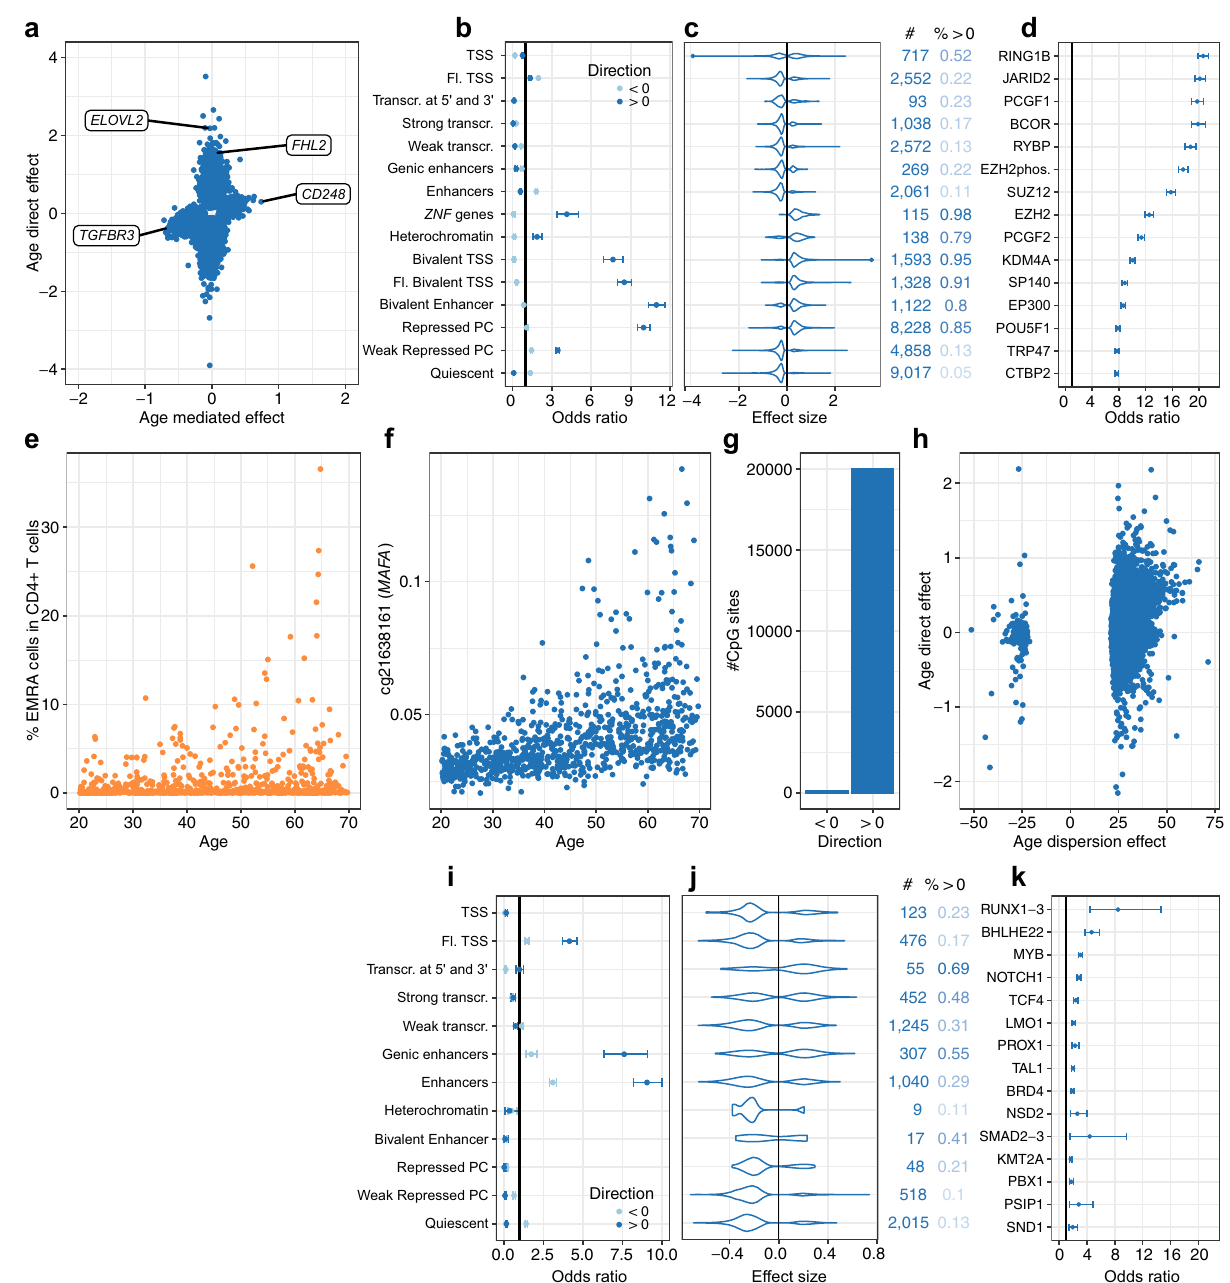
Fig.3|Directandcell-composition-mediatedeffectsofagingonthebloodDNA methylome. a Direct effects against cell-composition-mediated effects of age on